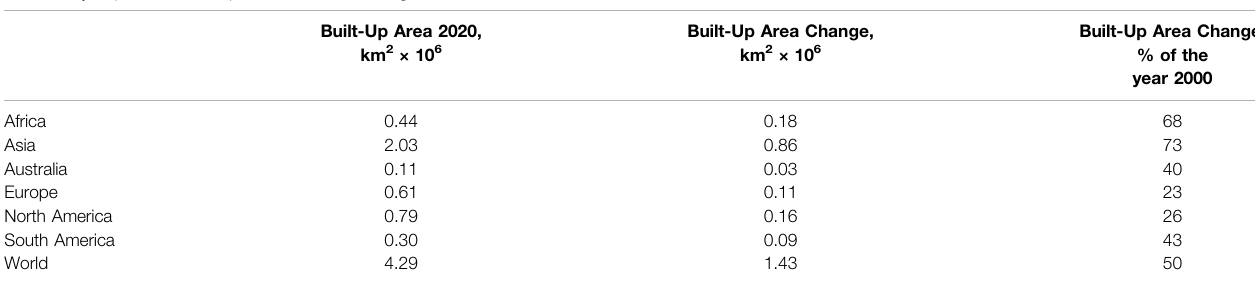
TABLE 4 | Map-based built-up lands area and change, 2000 – 2020.